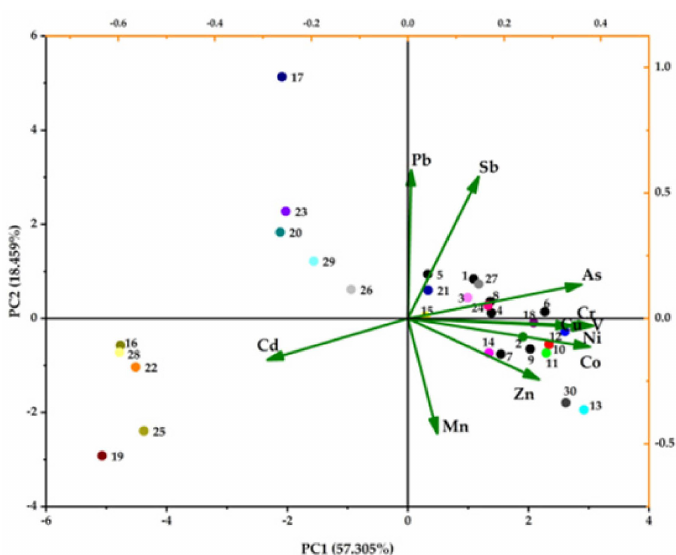
Figure 6. The PCA biplot of 11 PHTEs and 30 samples in the Jiulongchi wetland. The di ff erent color dots and the numbers next to them represent the collected 30 samples and corresponding